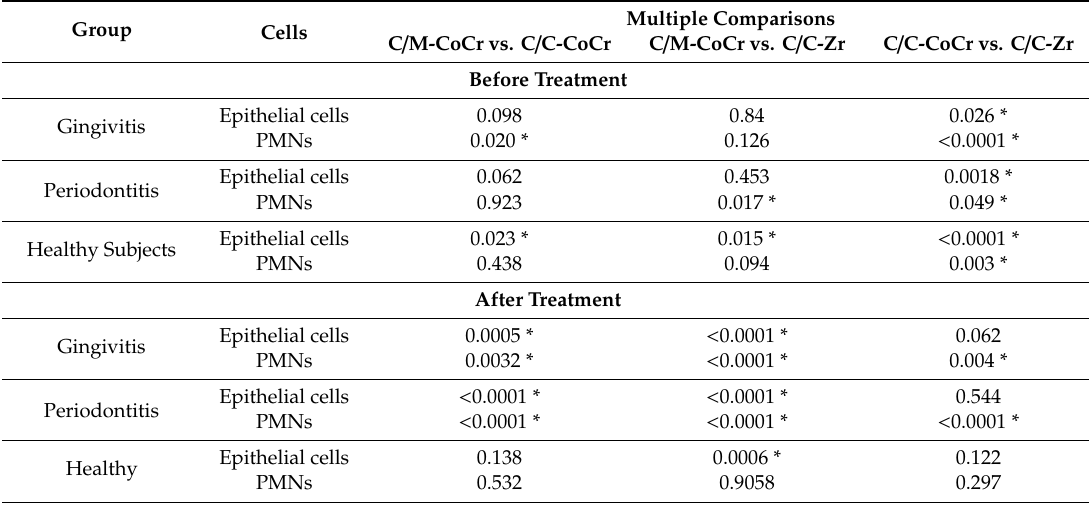
Figure 2. The mean epithelial cells / leukocytes ratios in gingivitis, periodontitis, and healthy (control) subjects. C / M-CoCr = Cobalt-chrome metal-ceramic prostheses by the conventional method; C / C-CoCr = Cobalt-chrome metal-ceramic prostheses by CAD / CAM technique and C / C-Zr = zirconia-based ceramic prostheses by CAD / CAM technique. Table 2. Comparison of the dynamics of cytomorphometric indicators in the three fixed prostheses groups among patients with gingivitis, periodontitis, and healthy subjects, before and after treatment.